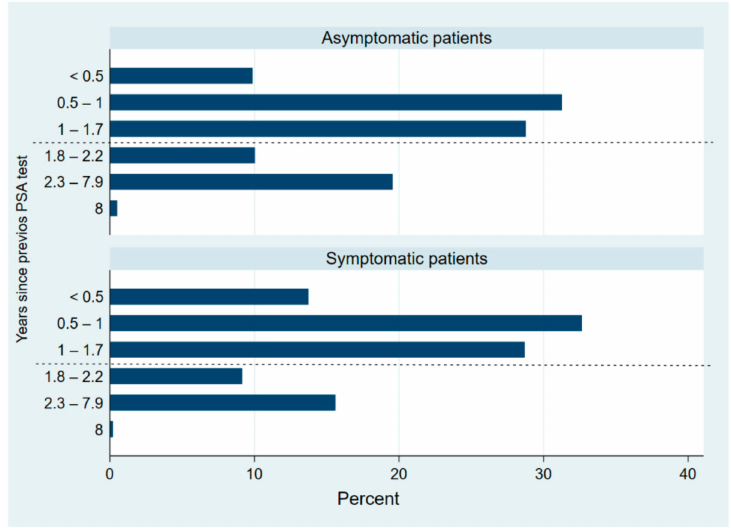
Figure 1. Distribution of interval from previous PSA test by subgroups (asymptomatic and symp- tomatic patients). Dash line marks minimum recommended interval between PSA tests (approxi- mately two